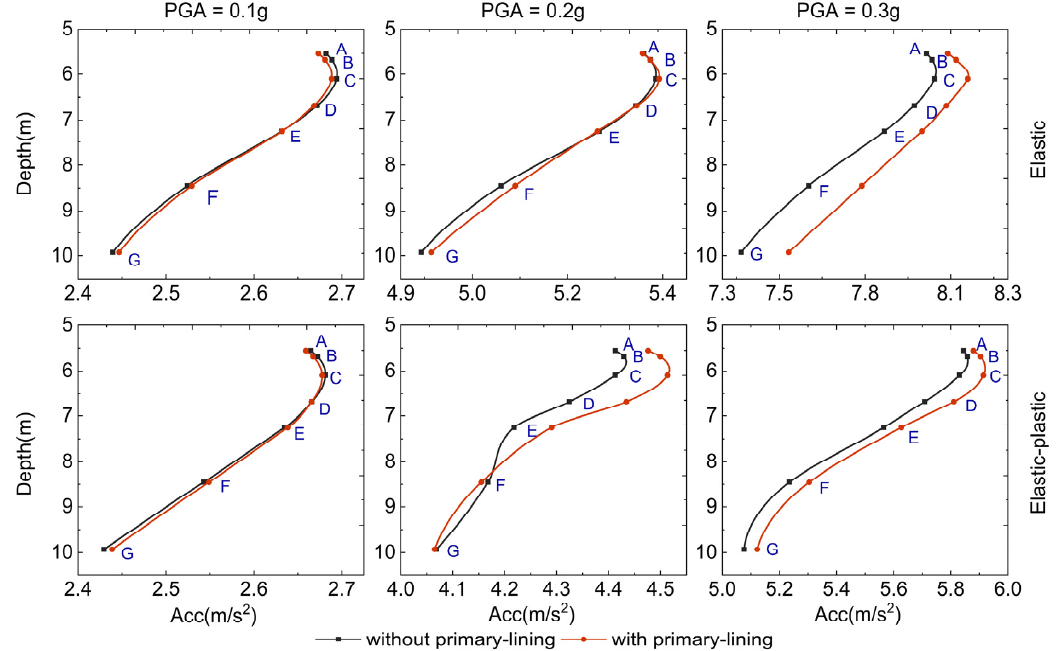
Figure 12. Horizontal acceleration amplification along the tunnel.